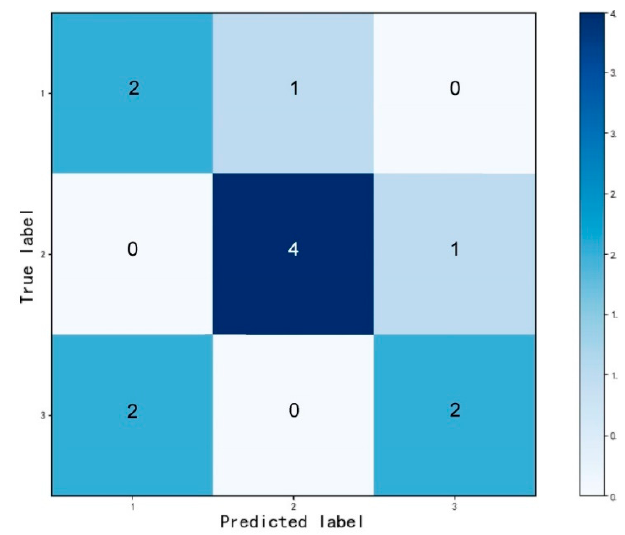
Appl. Sci. 2019 , 9 , x FOR PEER REVIEW Figure 6. The confusion matrix of the support vector machine (SVM) classification model.